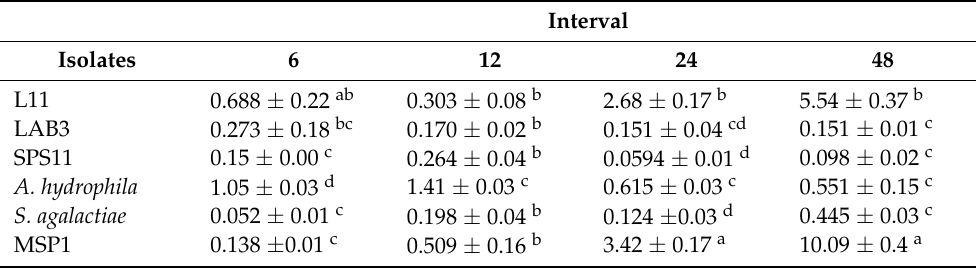
Table 3. Biofilm-forming ability of SSPs, pathogens and MSP1 at different time interval.